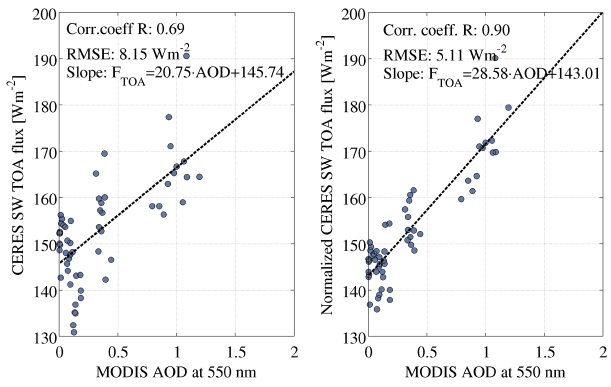
Figure 5. An example of the linear regression between CERES TOA fluxes and MODIS AODs without (left panel) and with (right panel) the normalization of the observed fluxes. This example shows the linear fit for October 2009 in a 0.5 × 0.5 ◦ grid cell where the Xianghe AERONET station is located. For each month a simi- lar linear fit has been carried out in all of those grid cells where the requirements for a successful regression were